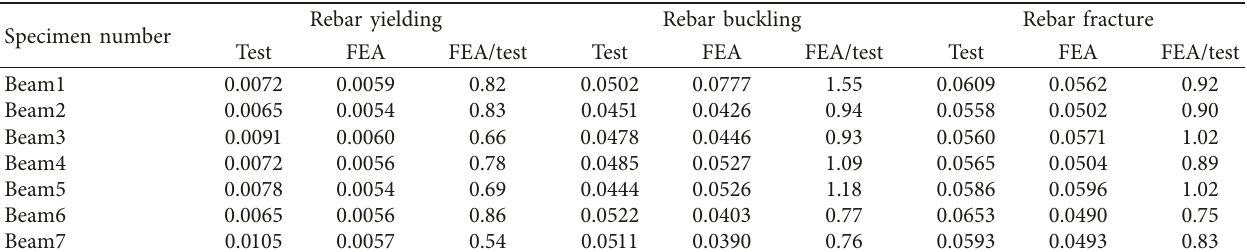
Table 7: Comparison of chord rotations of specimens for different rebar damage